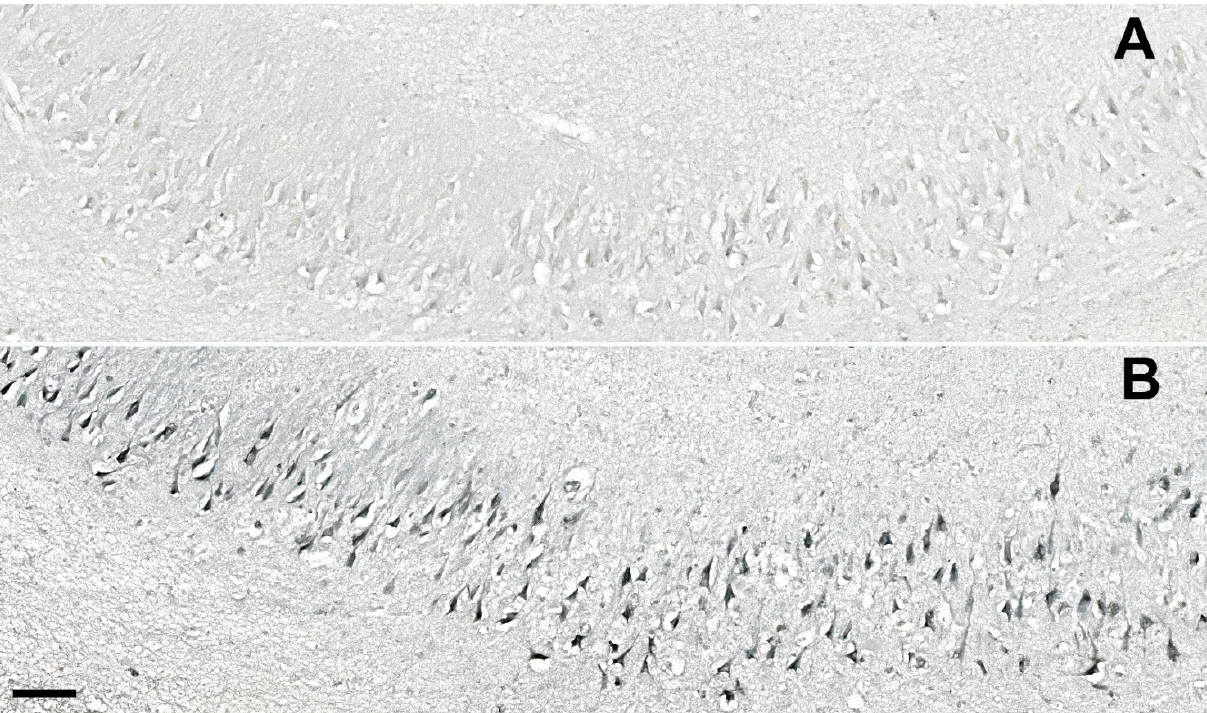
Figure 8. Immunostaining of NLRP1 in the CA2/3 field of the hippocampal formation in a control ( A ) and AD ( B ). See Figure 1 for quantitative data. Scale bar (same for A and B) = 100 μ m.